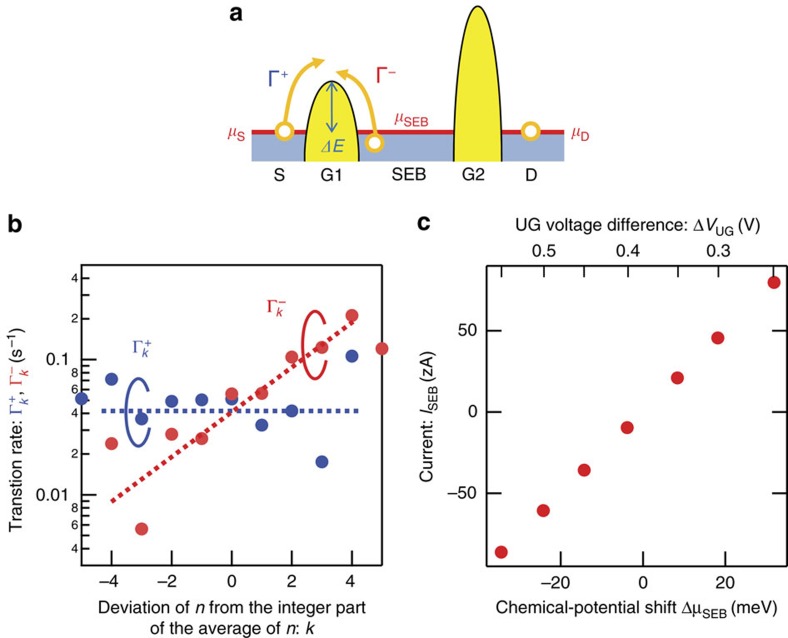
Directionally asymmetric electron transport in transistors.(a) Energy-band diagram along the S and D, where μS, μD and μSEB are chemical potentials at the source (S), drain (D) and single-electron box (SEB). For simplicity, we consider the electron shuttling between the S and SEB. Γ+ and Γ− are transition rates from the S and SEB, respectively. ΔE is energy barrier height when an electron in the S surmounts the energy barrier. (b) Transition rates Γk+ and Γk− as a function of k, which is the deviation in n from the integer part of the average. They are the transition rates for electrons to enter (+) and leave (−) the SEB at k. The dotted lines show expected values. The details are explained in Supplementary Note 3. Since the number of data points at |k|>4 is relatively small, there are large errors at |k|≥4. (c) Current across the SEB ISEB generated by periodic switching without feedback, estimated with single-electron counting statistics, as a function of the shift in μSEB (ΔμSEB) when the state is switched from A to B. The upper axis depicts ΔVUG, which is the difference in voltage applied to the upper gate (UG) when the state is switched from A to B. State A and B are alternately switched every 4 s. Current is given by Δne/8, where Δn is the number of electrons transferred from S to D when the state is switched from A to B. The factor of 8 originates from the time it takes for the state changes from A to B and back to A, that is, 2 × 4 s. The details, including the evaluation of ΔμSEB, are explained in Supplementary Note 4.